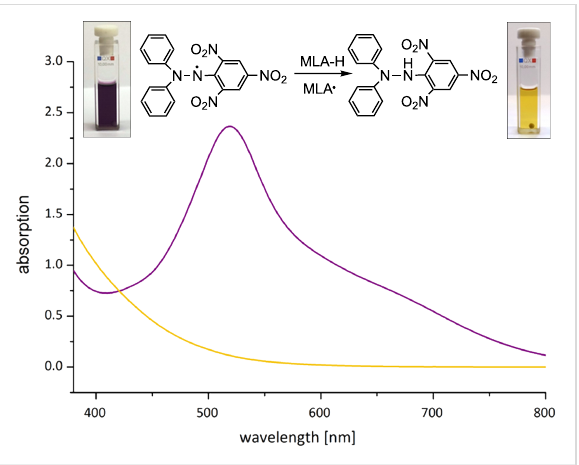
Figure 6: UV–vis spectra of the reaction mixture with DPPH radical at the beginning (violet line, 0.23 mM) of the self-initiated polymerization of MLA and after 15 h (yellow line) in a range from 380–800 nm ( c MLA = 1.8 mol L − 1 , 70 °C).